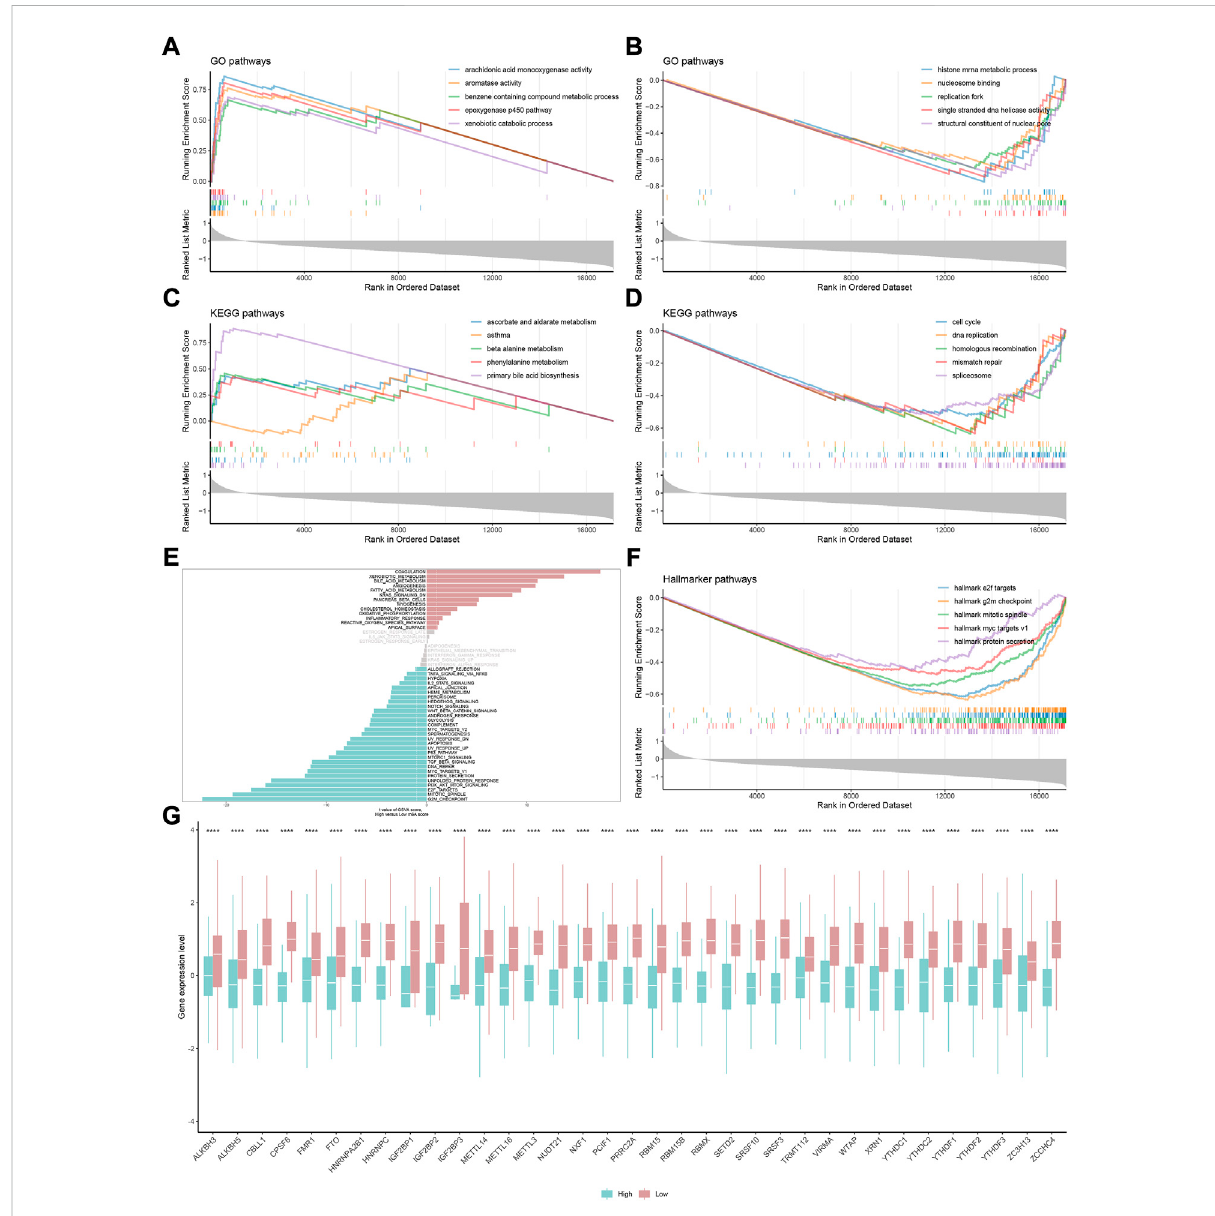
FIGURE 7 Gene set enrichment analysis underlying the m6A signature in HCC. (A) Most signi fi cantly enriched GO terms in the high-m6Ascore group. (B) Most signi fi cantly enriched GO terms in the low-m6Ascore group. (C) Most signi fi cantly enriched KEGG pathways in the high-m6Ascore group. (D) Most signi fi cantly enriched KEGG pathways in the low-m6Ascore group. (E) Gene set variation analysis underlying the m6A signature. (F) Most signi fi cantlyenrichedhallmarkpathwaysinthelow-m6Ascoregroup. (G) Differenceintheexpressionlevelof35m6Aregulatorsbetweenhigh- and low-m6Ascore groups (* p < 0.05, ** p < 0.01, *** p < 0.001, **** p < 0.0001, and ns, not signi fi